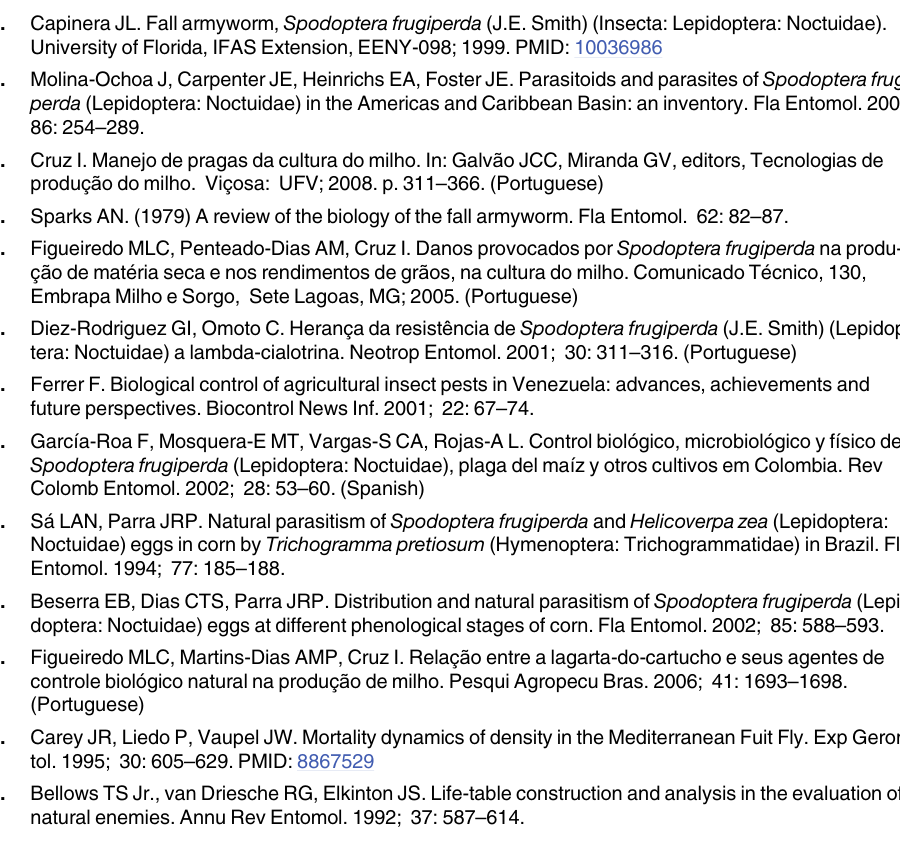
S2 Table. Total number of Spodoptera frugiperda larvae evaluated for life table analysis.